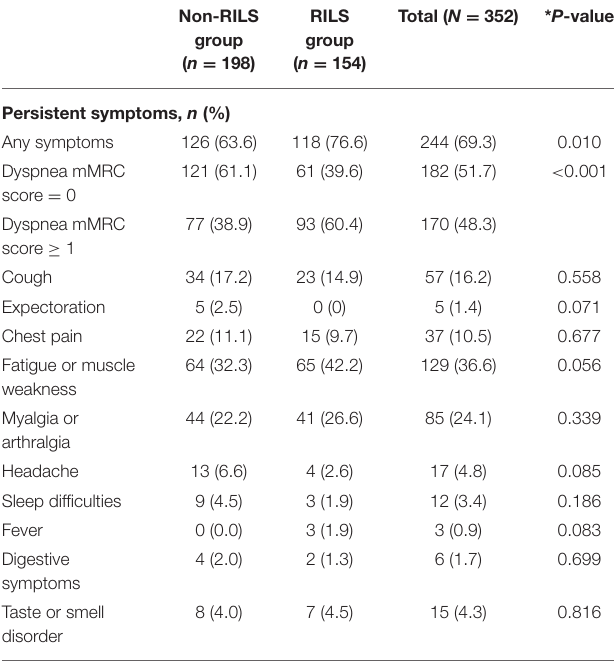
TABLE 2 | Baseline characteristics of the study population. Characteristics